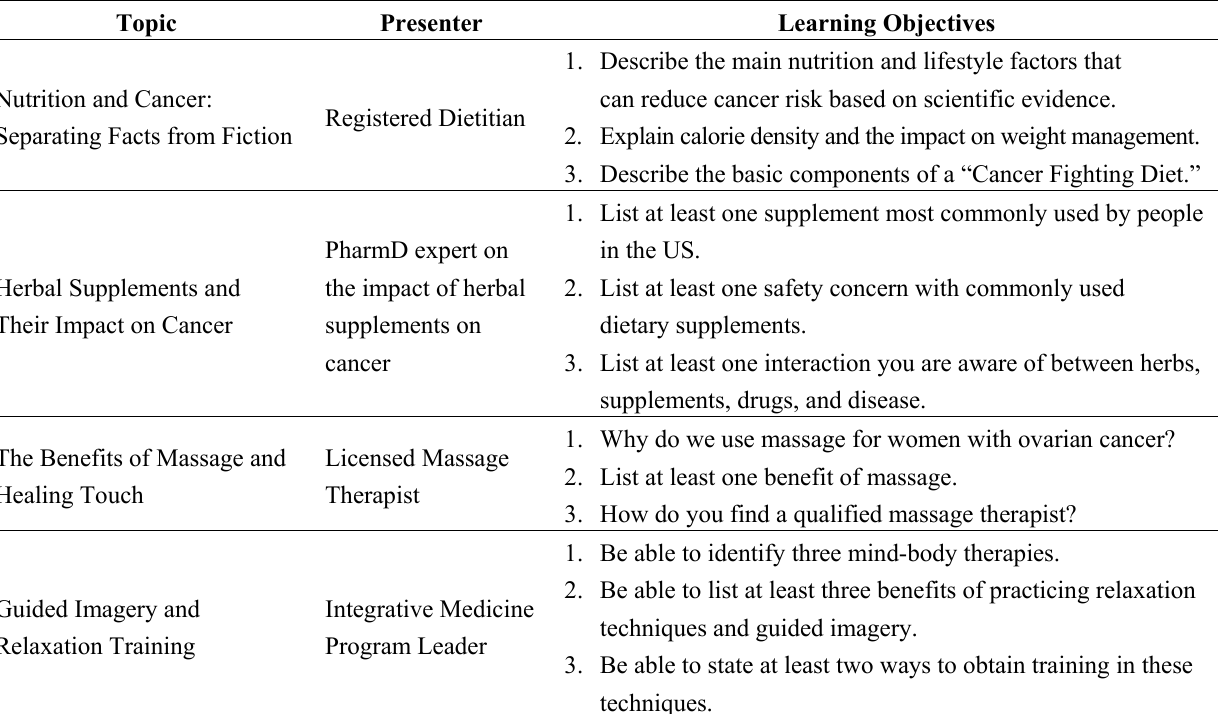
Table 1. Topics, presenters, and learning objectives for the four education